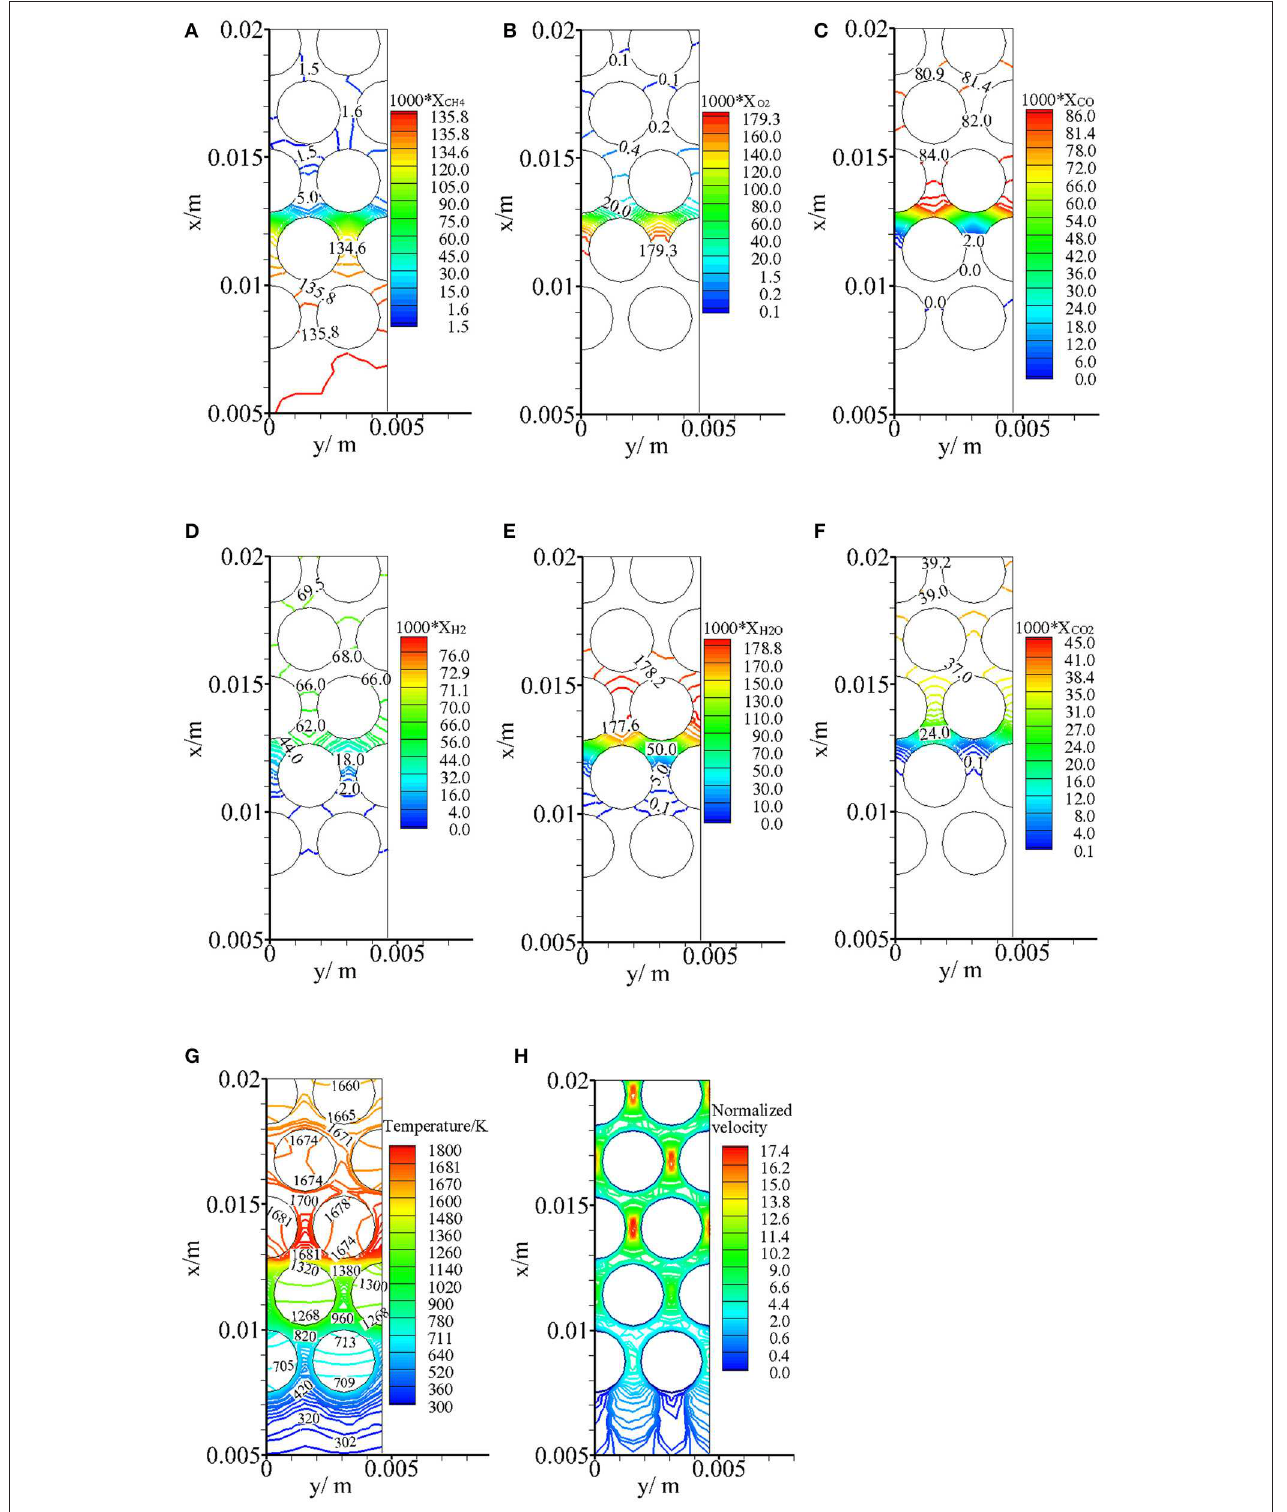
FIGURE 4 | Predicted molar fractions of CH 4 , O 2 , CO, H 2 , H 2 O, CO 2 , temperature profiles, and normalized velocity distributions near the exothermic zone for α and φ 1.5. (A) X CH4 , (B) X O2 , (C) X CO , (D) X H2 , (E) X H2O , (F) X CO2 , (G) Temperature (K), and (H) Normalized velocity. =